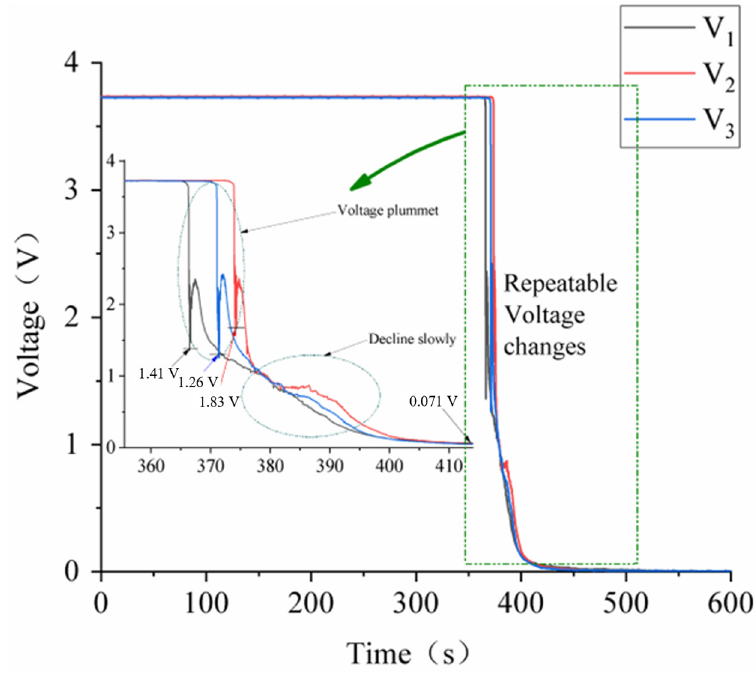
Figure 4. Same SOC battery time voltage curve.